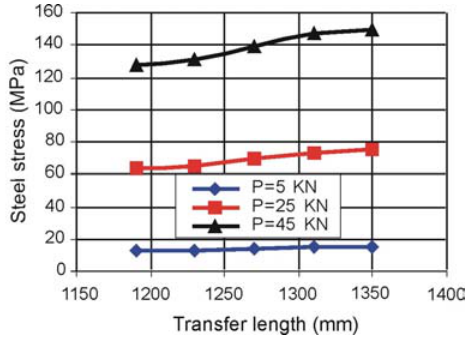
Fig. 12. Steel stress; s σ over the transfer length